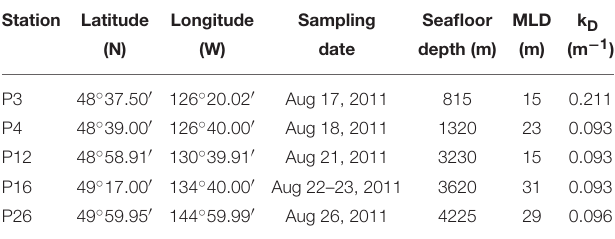
previously reported for summer months along Line P (0.80–1.35 × 10 9 cells L − 1 and 2–6 μ g C L − 1 d − 1 , respectively) (Sherry et al., 1999).